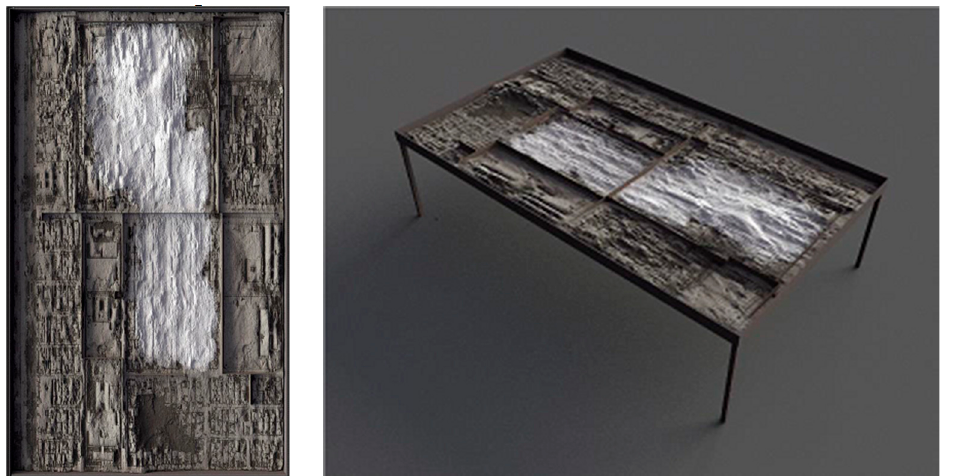
Figure 14. Ronen Sharabani, Basrah #4 , from the series Virtual Territories , 2019. Digital print.